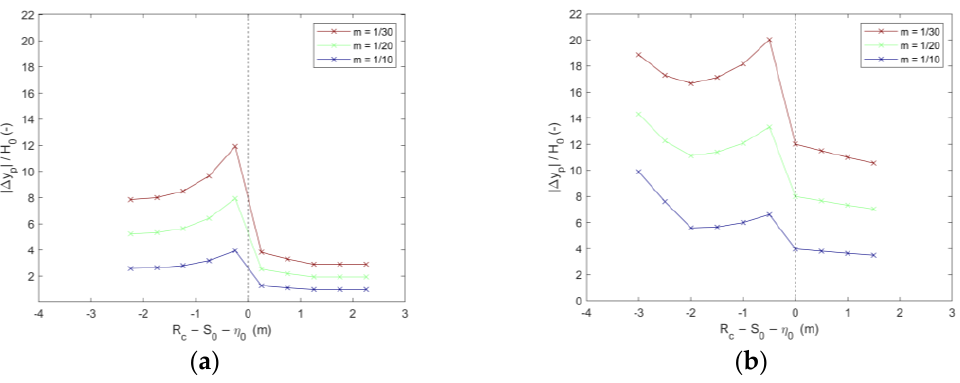
Figure 10. Relative shoreline recession (| Δ y p |/H 0 ) for beaches protected by breakwaters for 2 differ- ent values of sea level rise: ( a ) for S 0 = 0.2 m; ( b ) for S 0 = 1.0 m. Dependence from m , constant values: H 0 = 4 m, B = 8 m, h t = 3 m, T = 9 s.